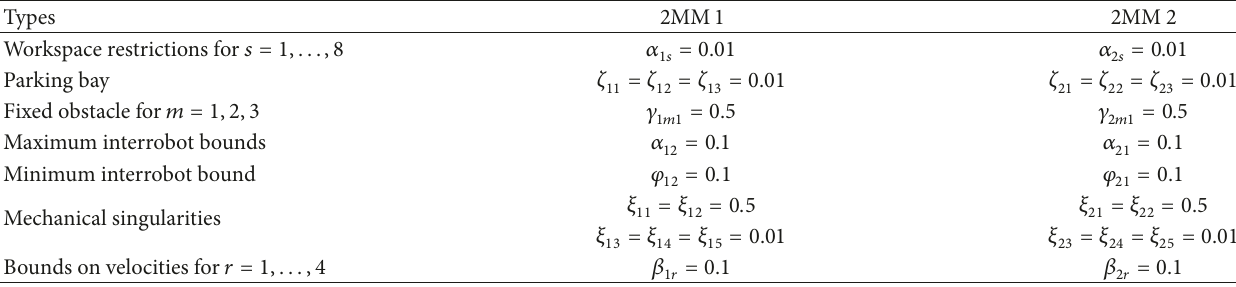
Table 1: Scenario 1 : tuning parameters.